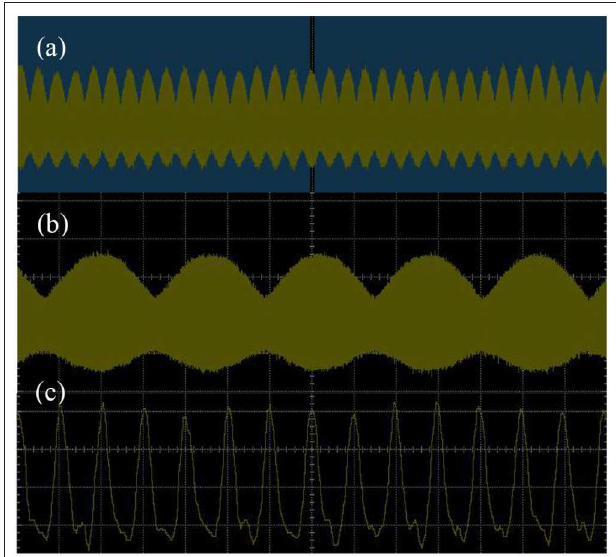
FIGURE 4 | Mode-locked pulse sequence recorded in (A) 1 ms, (B) 100 µ s, and (C) 10 ns per division (div)